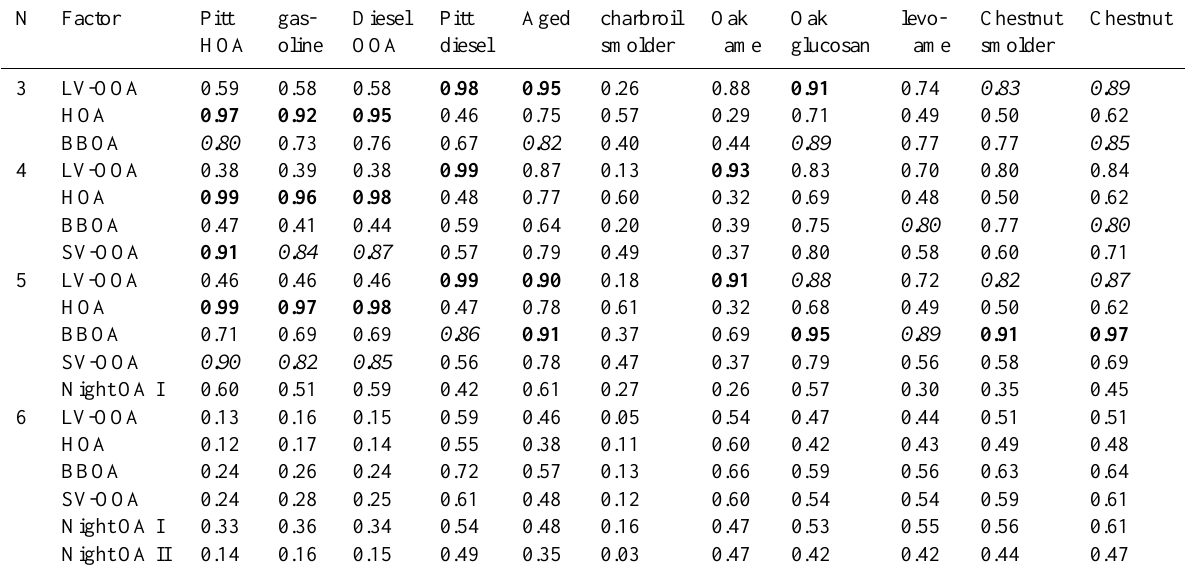
Table 1. Correlation ( r 2 ) of PMF factor profiles with Pittsburgh 1 OOA PMF profile, Pittsburgh HOA PMF profile, diesel exhaust source